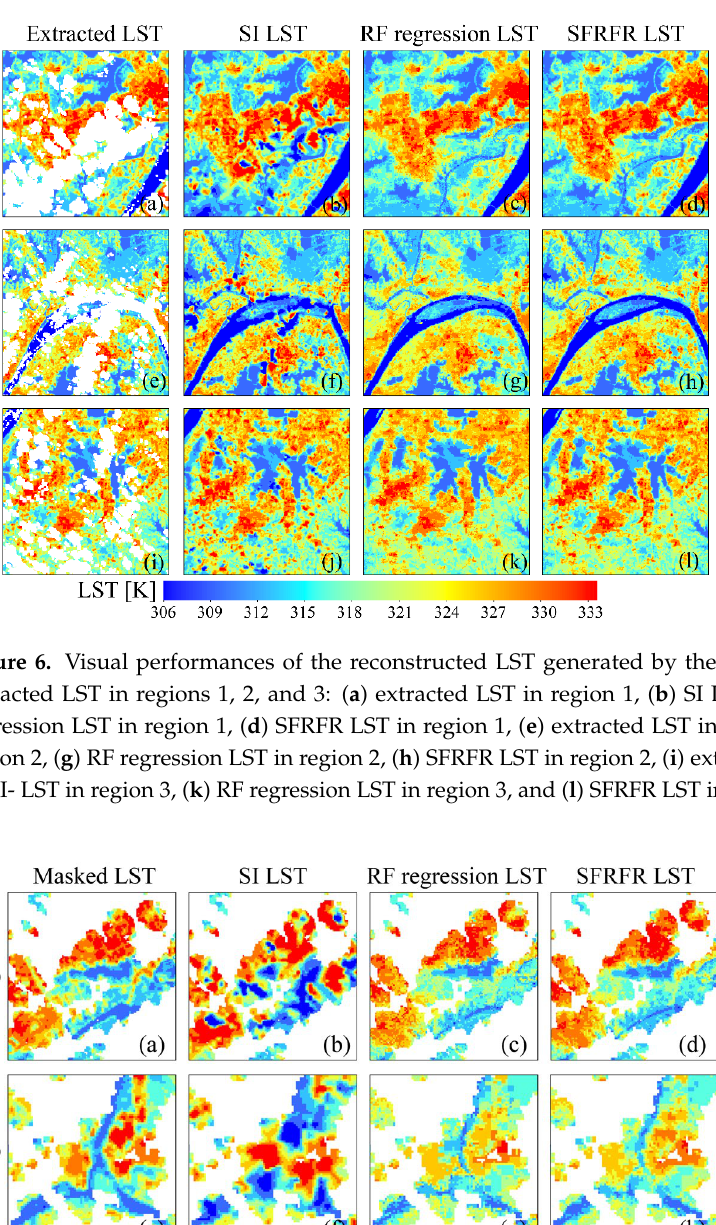
Figure 7. Detailed performances of the predicted LST in the subregions of the masked LST: ( a ) masked LST in subregion 4, ( b ) SI LST in subregion 4, ( c ) RF regression LST in subregion 4, ( d ) SFRFR LST in subregion 4, ( e ) masked LST in subregion 5, ( f ) SI LST in subregion 5, ( g ) RF regression LST in subregion 5, ( h ) SFRFR LST in subregion 5, ( i ) masked LST in subregion 6, ( j ) SI LST in subregion 6, ( k ) RF regression LST in subregion 6, and ( l ) SFRFR LST in subregion 6.